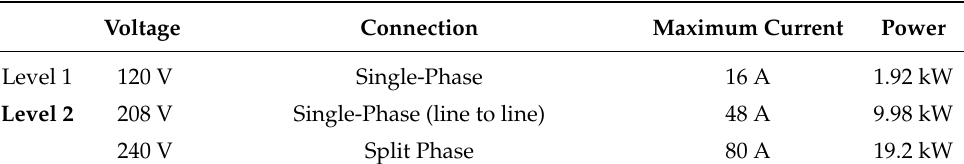
Table 1. Overview of EV AC charging levels in North America [3,31].